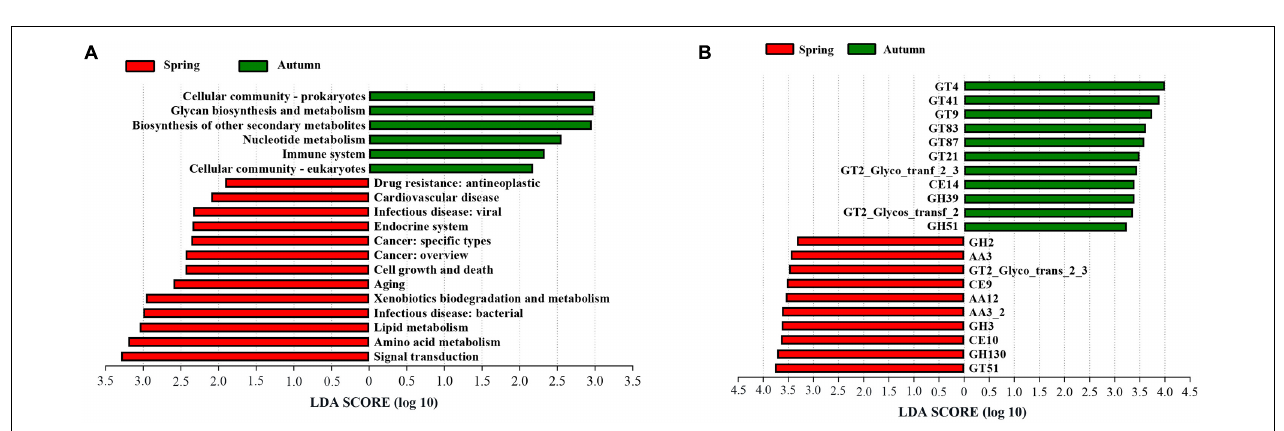
FIGURE 7 | Functional predictions for phyllosphere bacterial communities with significantly different KEGG pathways ( P < 0.05) for the three bamboo species (AS, FF, and YL). KEGG pathways at Level 1, Level 2, and Level 3 are represented. *0.01 < P < 0.05, **0.001 < P < 0.01.